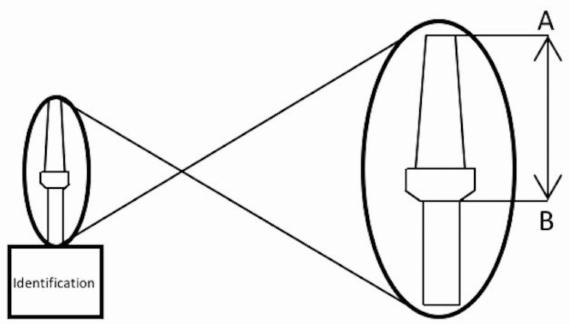
Figure 2. A–B distance (mm). A: A–B distance (distance between the implant platform to the top of the abutment). The letter A represents the maximum height of the abutment and the letter B represents the base of the